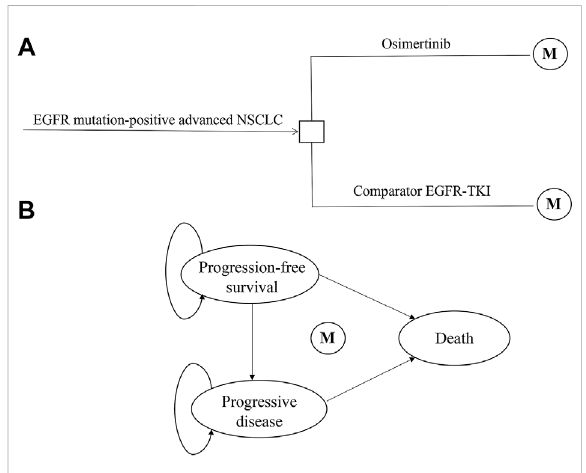
FIGURE 1 Model structure of a decision tree combining the Markov state transition model with the three health states. (A) Decision tree. (B) Markov state transition model. Abbreviations: M, Markov node; EGFR-TKI, epidermal growth factor receptor – tyrosine kinase inhibitor; NSCLC, non-small-cell lung